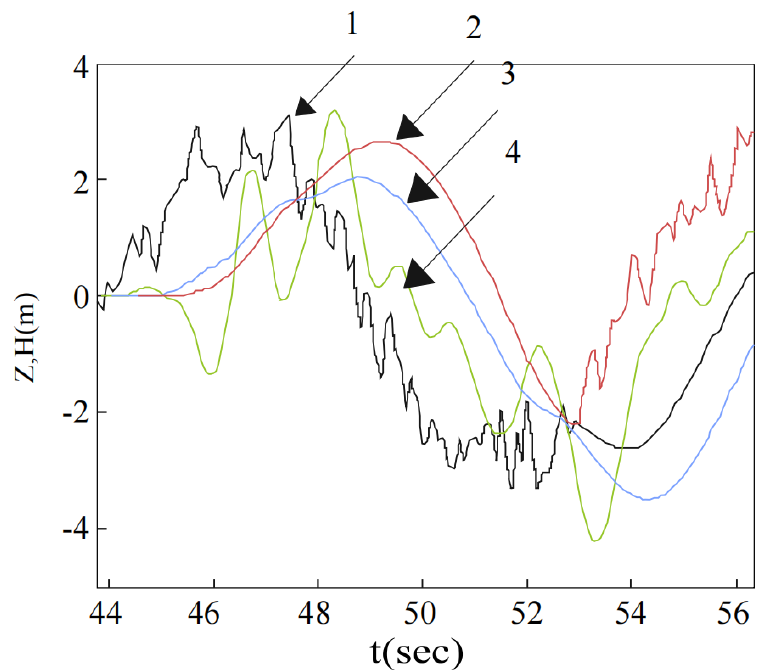
Figure 12. The response curve of aircraft tracking deck motion after introducing deck motion compensator, where black curve 1 is the up and down motion curve, red curve 2 is the aircraft motion curve without the deck motion compensator DMC , blue curve 3 is the aircraft motion curve with the deck motion compensator DMC 1 and green curve 4 is the aircraft motion curve with the deck motion compensator DMC 2 .